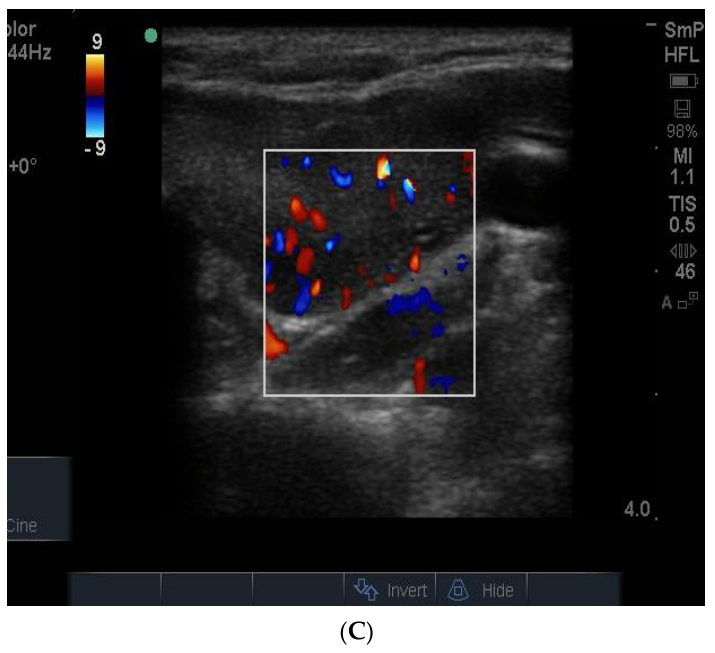
Figure 15. Thyroid ultrasound from two patients with Graves' hyperthyroidism. In ( A ) is shown an example of early Graves’ hyperthyroidism manifest as multiple small inflammatory and lymphoid lesions, often described by the consultant radiologist as “nodules” blue arrow. In ( B ) is shown an enlarged thyroid, with a thick isthmus and a generalized patchy hypo echoicity due to the lymphocytic inflammation and thyroid cell proliferation. In ( C ) is shown the increased vascularity in the thyroid of the patient shown in ( B